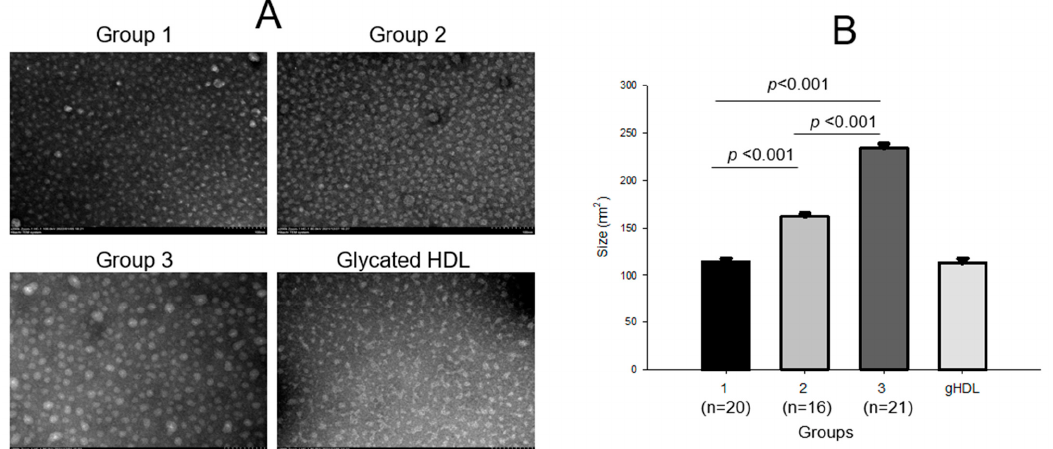
Figure 3. Transmission electron microscopy (TEM) images and area analysis of HDL 2 from each group ( A ) and size comparison between the groups ( B ). gHDL, glycated HDL.